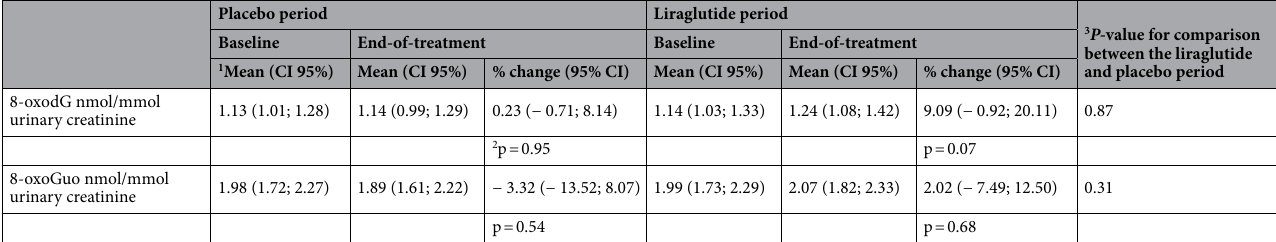
Table 2. Outcome measures for the LIRALBU trial. 1 Geometric mean with 95% confidence interval. 2 Paired- samples t-test. 3 Unadjusted linear mixed